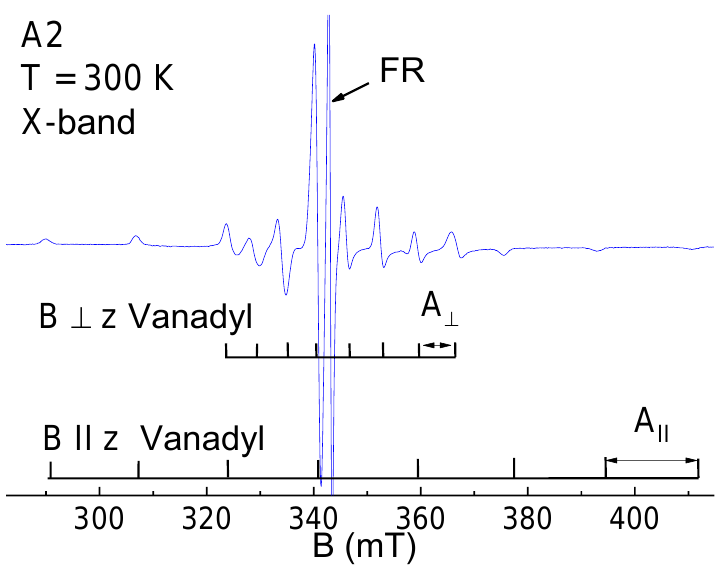
Figure 2. X-band CW EPR for an A2 fraction.